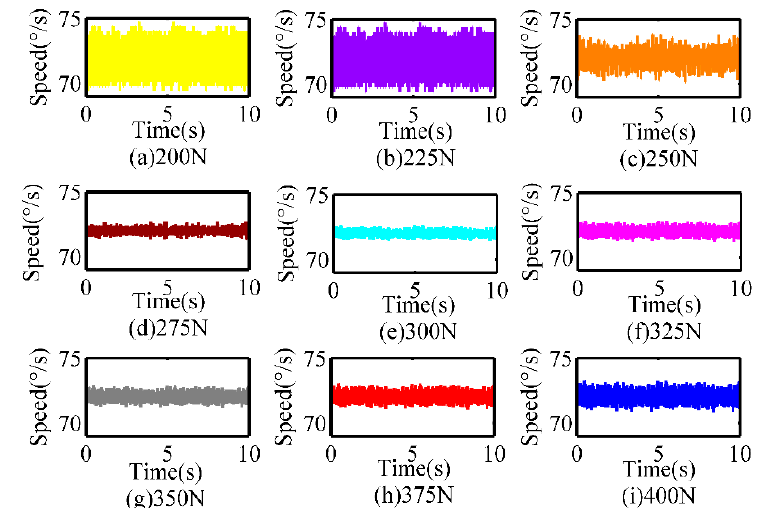
Figure 10. Comparison of the speed control performance under different pre-pressures.